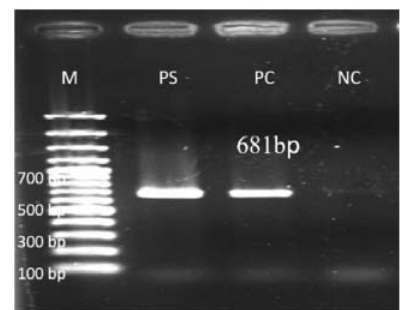
Fig. 2. Negative result of rapid antigen detection (Only control band is visible).